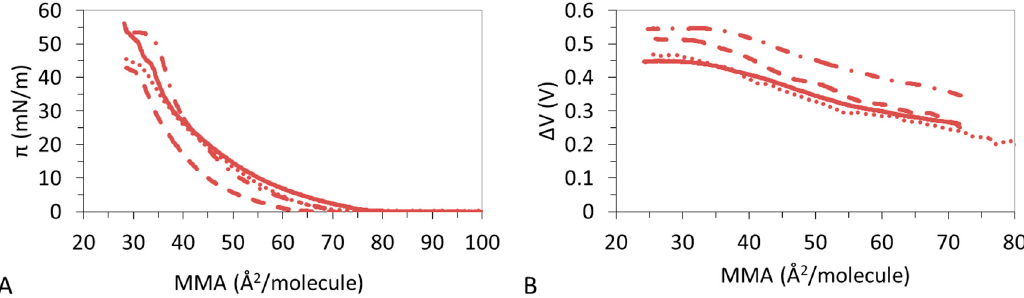
Figure 7. E ff ect of electrolyte on DPPC:DPPS:CHOL-30 monolayers. ( A ) π - A and ( B ) ∆ V – A isotherms. 15 mM NaCl (straight line), 5 mM CaCl 2 (dashed line), 5 mM MgCl 2 (dash-dotted line), 2.5 mM LaCl 3 (dotted line). Curves replotted from Figures 1 and 2.